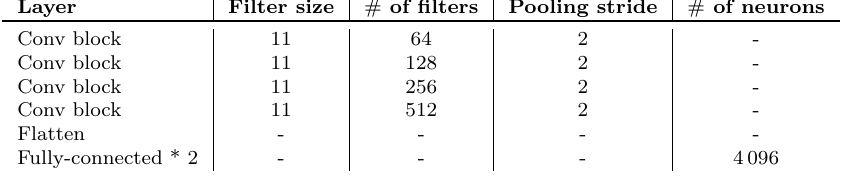
Table 3: CNN architecture used for